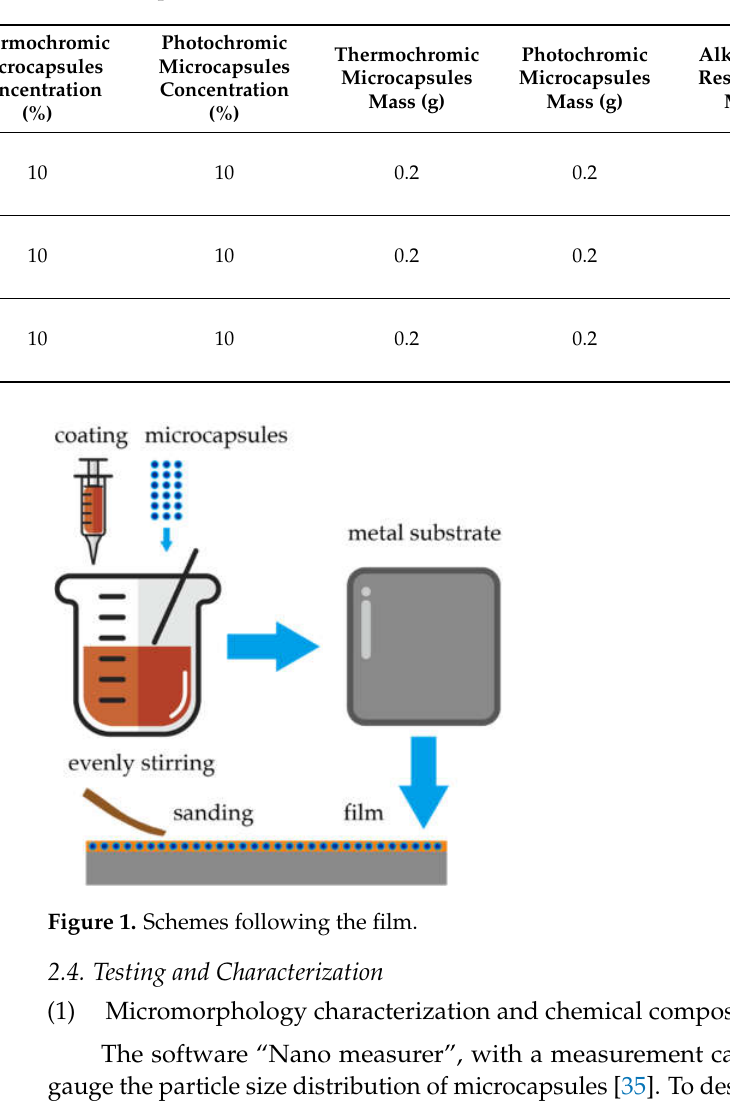
Table 1. Experimental materials list.